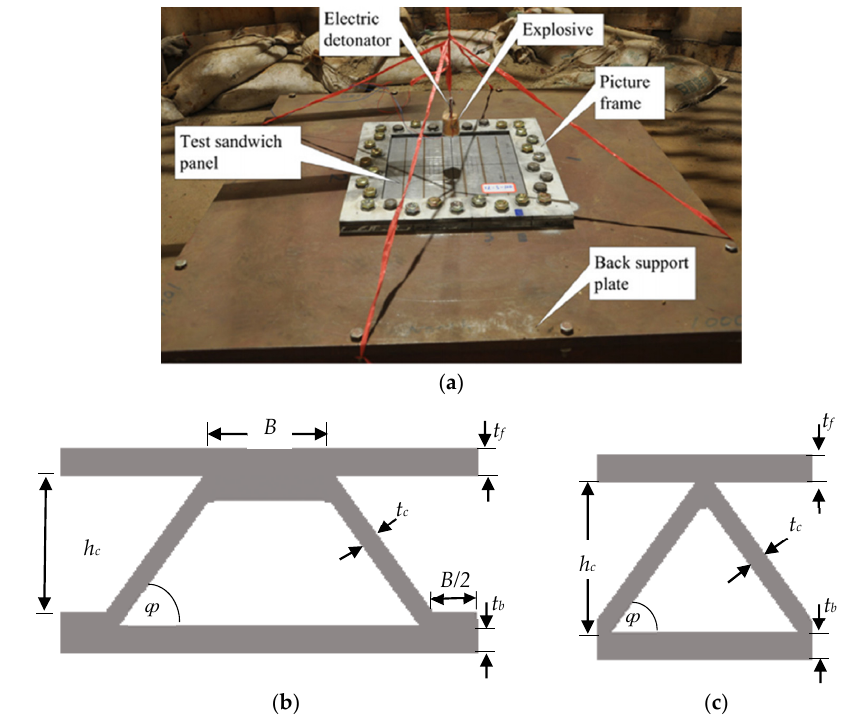
Figure 1. Schematics of ( a ) an experimental set-up, ( b ) trapezoidal (TZ)-panel cross-section unit cell, and ( c ) triangular (T)-panel cross-section unit cell. (reproduced from refs. [23,24]).